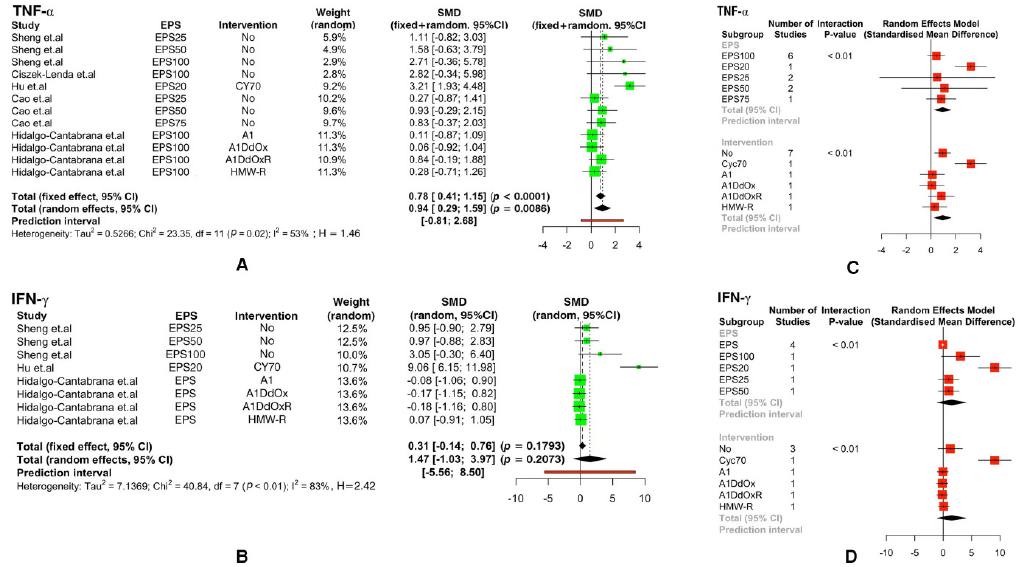
Figure 4 ． The forest plot illustrates the effects of extra-cellular polysaccharides on the immunity index of animals: ( A ) TNF- α ; ( B ) IFN- γ . Based on the above figure, a forest plot of the effect of using inter-fering media before EPS treatment and the effect of different concentrations of EPSs on immunity index was made: ( C ) TNF- α , ( D ) IFN- γ . (Positive and negative values indicate increases or de-creases in the production of immune factors. SMD: standardized mean difference.)